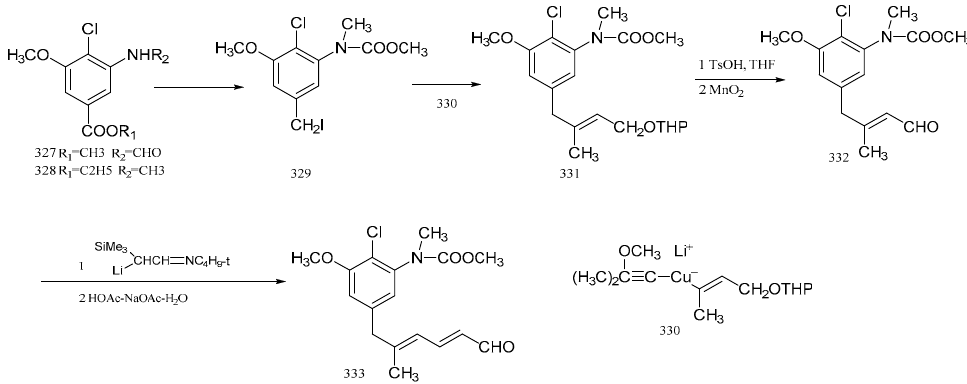
Figure 15. Synthesis of strategic intermediates corresponding to the C10-N fragment of maytansine.